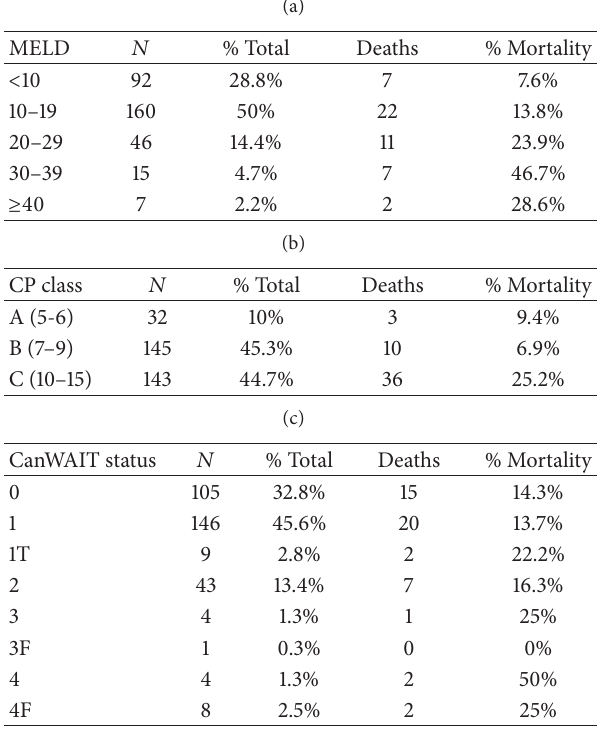
Table 3: The distribution of patients and overall mortality rates within MELD strata, CP classes and